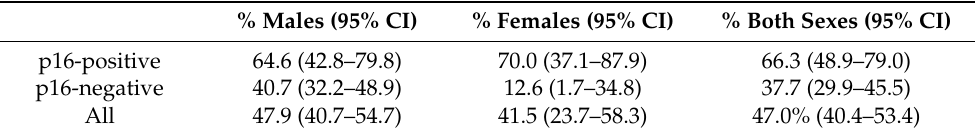
CI: confidence interval. 5-years observed survival in all cases has been analyzed used p16-positive and -negative and missing